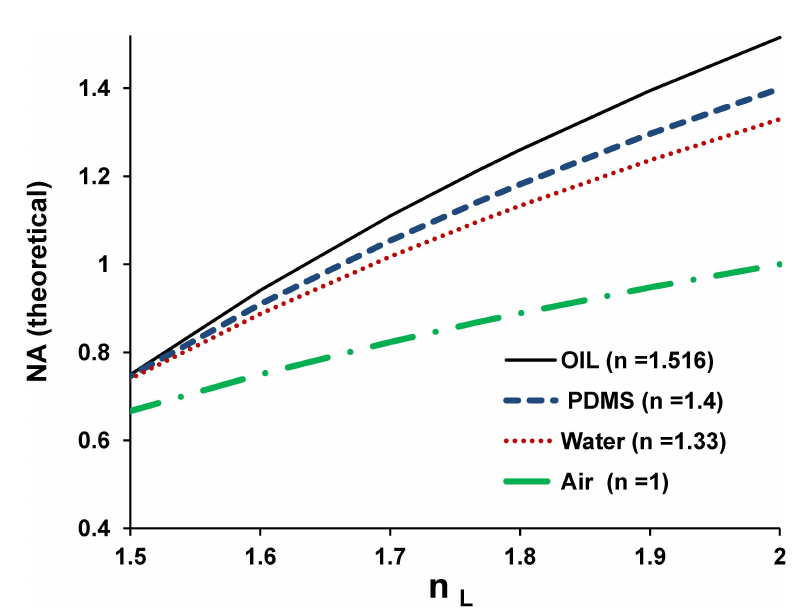
Figure 4. Numerical Aperture (NA) of the µOIL chip versus refractive index of the ball mini-lens ( n ) for four different cases of immersion media as theoretically predicted by L Equation